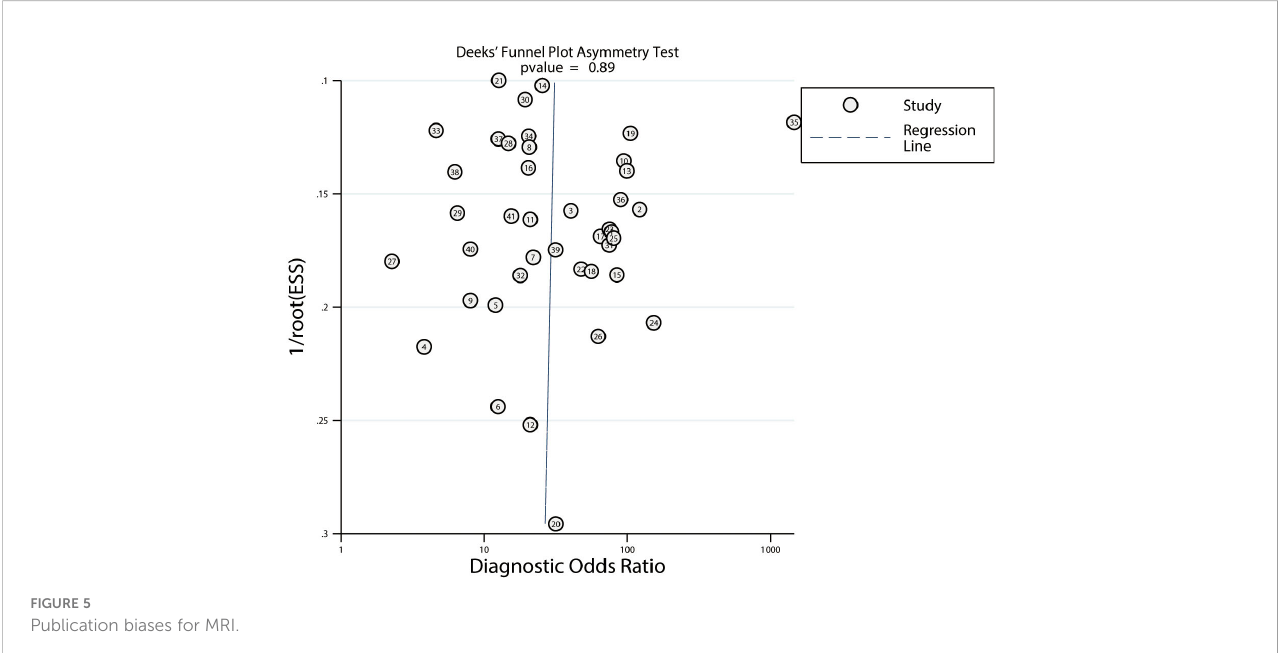
FIGURE 5 Publication biases for MRI.